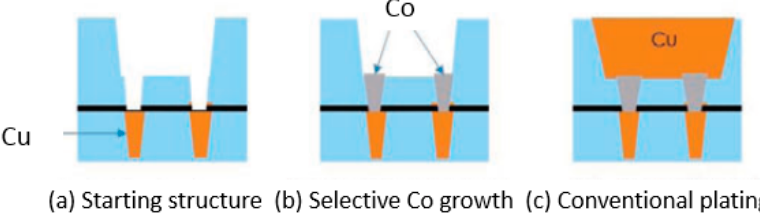
Figure 20. Integration of Co selective growth [148].